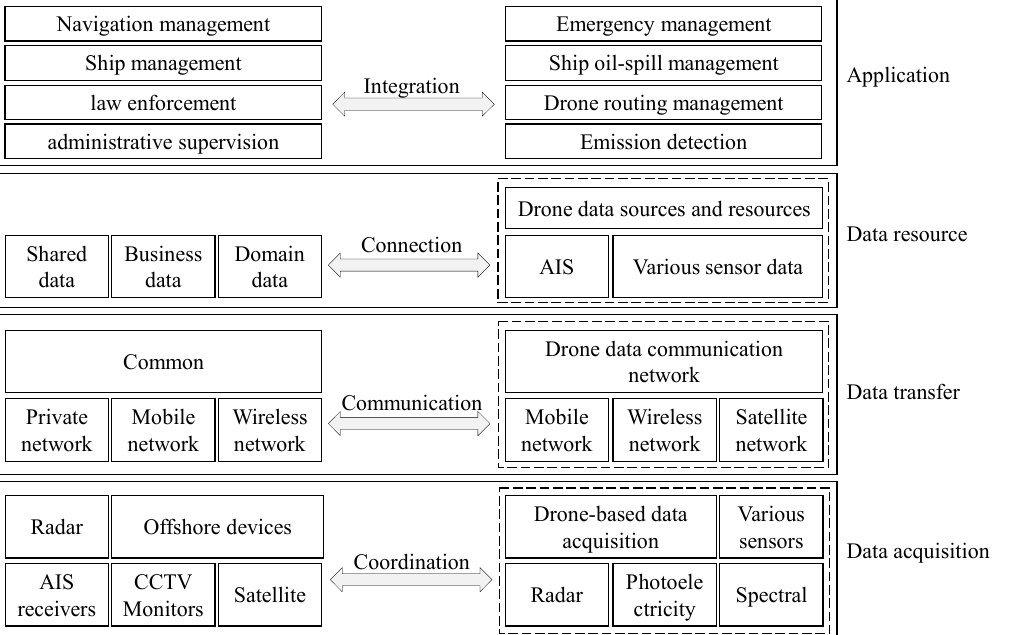
Figure 2. A system framework for drone-based ship management.